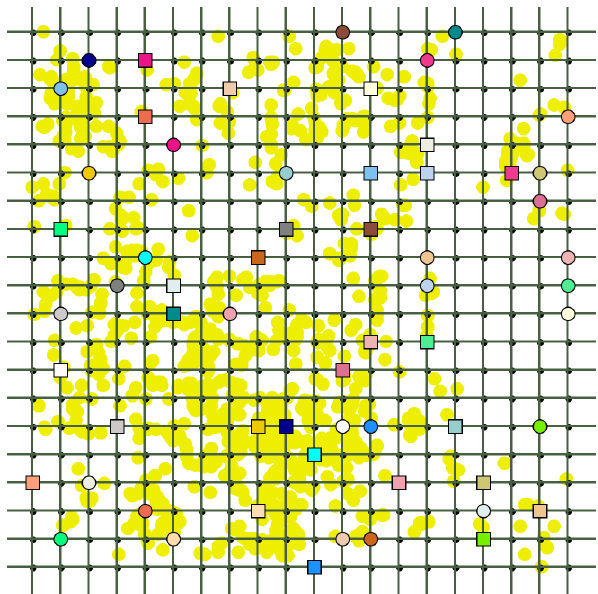
Figure 4. Grid system with 20 × 20 stops and 40 bidirectional lines. Square and circle of the same color correspond to the source and destination of an agent, respectively.